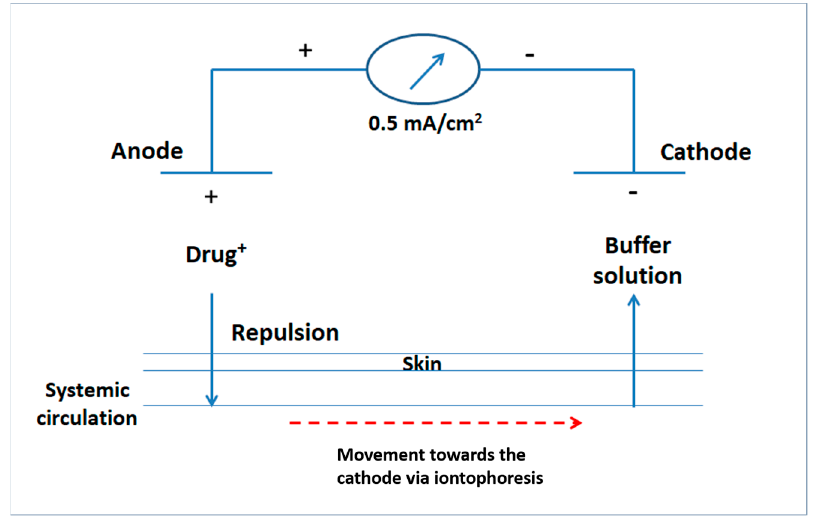
Figure 1. Schematic presentation of anodal iontophoresis.